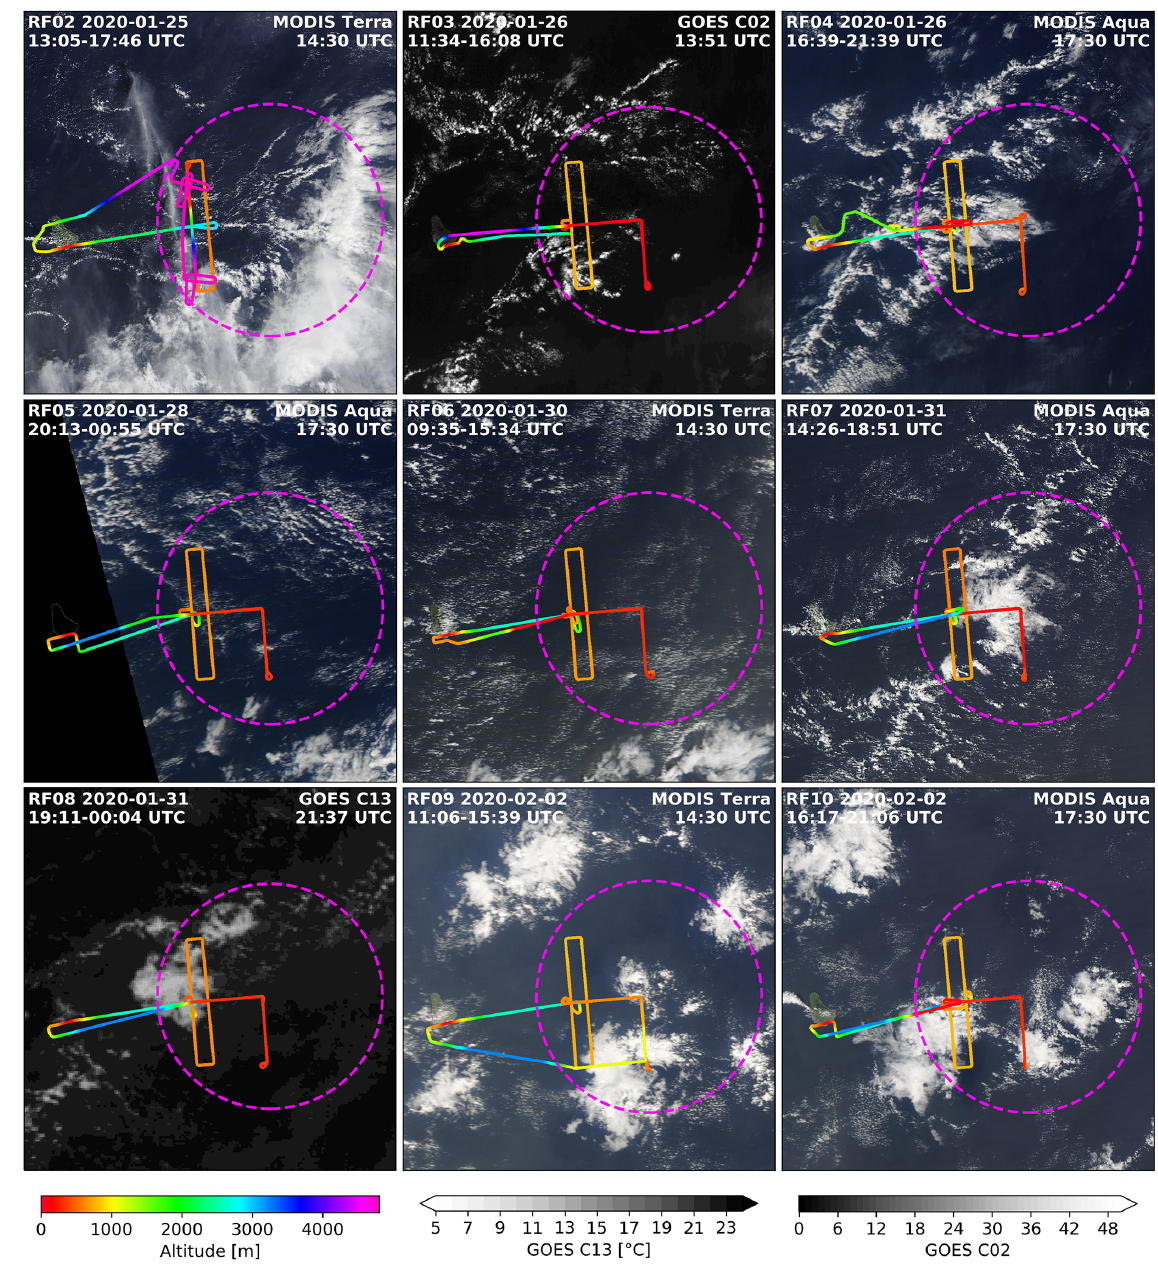
Earth Syst. Sci. Data, 14, 2021–2064,